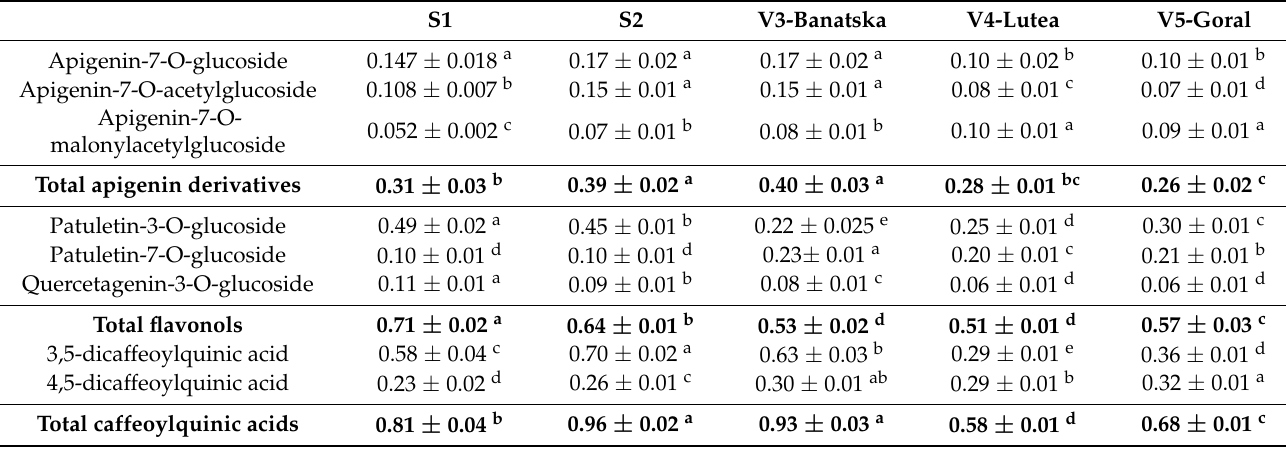
Table 2. Amounts (% w/w dry weight of herbal drug) of apigenin derivatives, flavonols and dicaffeoylquinic acid derivatives, in Matricaria recutita flowers ( r = 3).